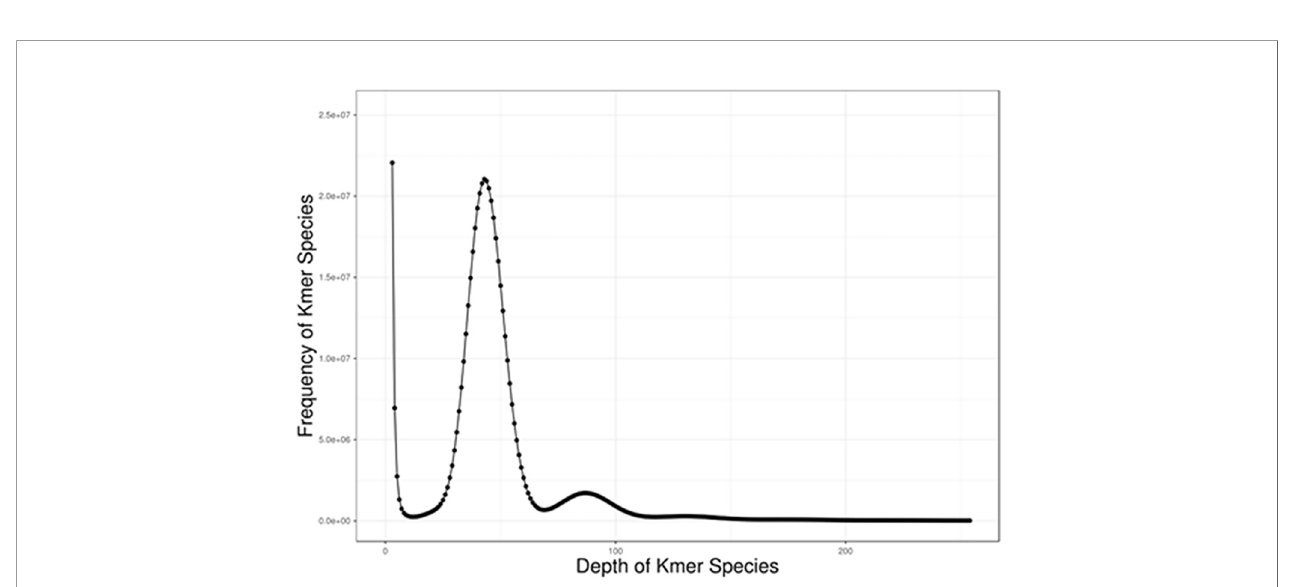
FIGURE 2 | The frequency of 17mer distribution from the whole-genome Illumina sequencing data. The peak around 45 represented the frequency of homozygous Kmers and that around 90 referred to the frequency of repeated